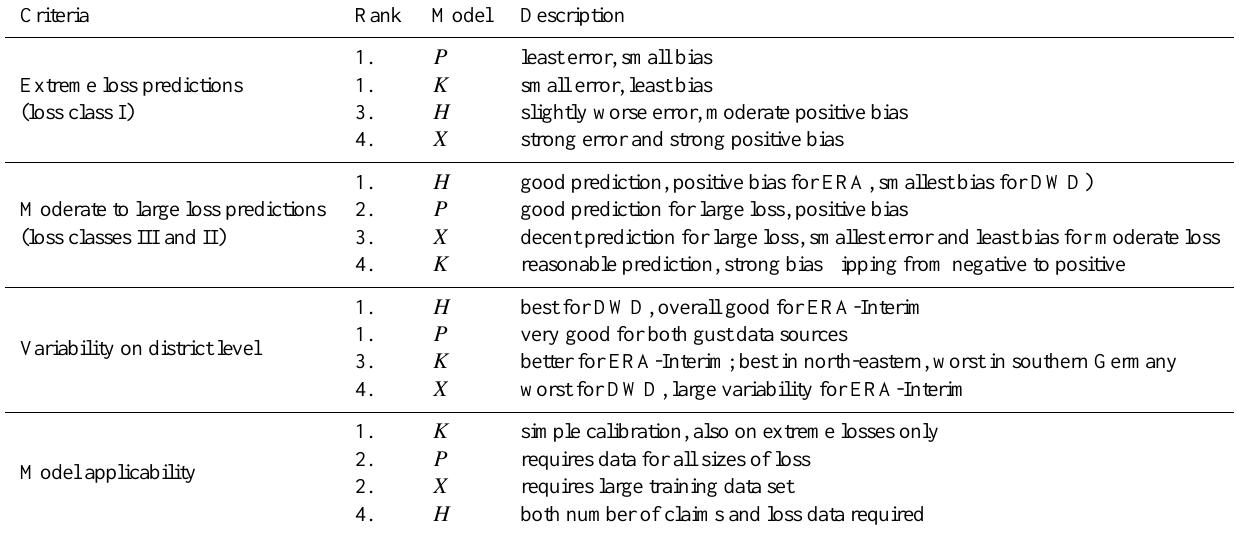
Table 6. Ranking of the four damage functions according to their prediction quality, variability, and applicability. Criteria Rank Model Description 1. P least error, small bias Extreme loss predictions 1. K small error, least bias 3. H slightly worse error, moderate positive bias 4. X strong error and strong positive bias 1. H good prediction, positive bias for ERA, smallest bias for DWD) 2. P good prediction for large loss, positive bias 3. X decent prediction for large loss, smallest error and least bias for moderate loss 4. K reasonable prediction, strong bias flipping from negative to